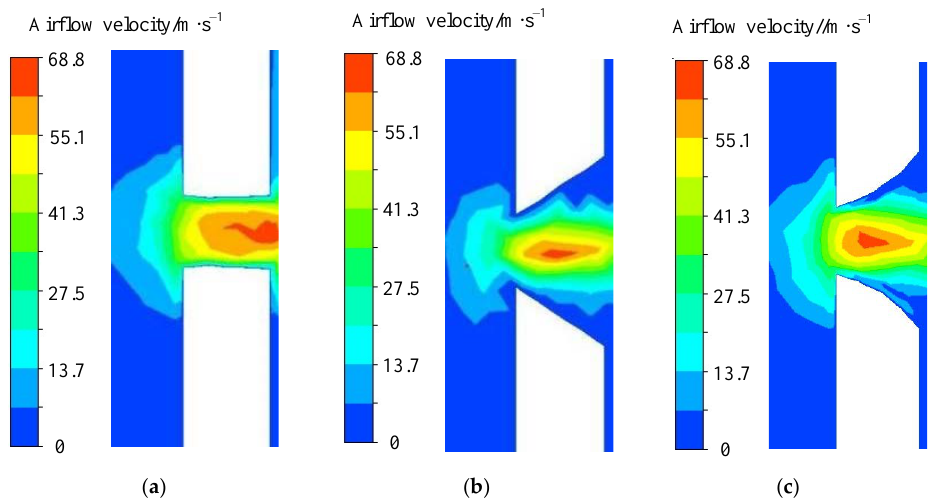
Figure 12. Air velocity contours of different structures of the seed disk holes. ( a ) cylindrical; ( b ) conical; ( c ) arc.